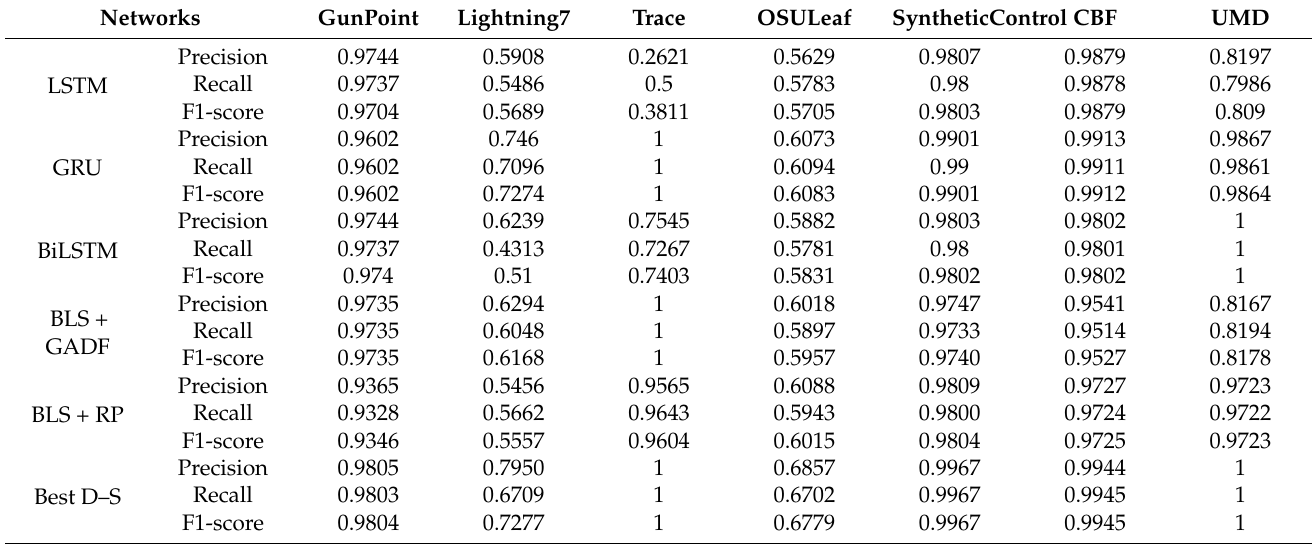
Table 5. Evaluation indexes of different